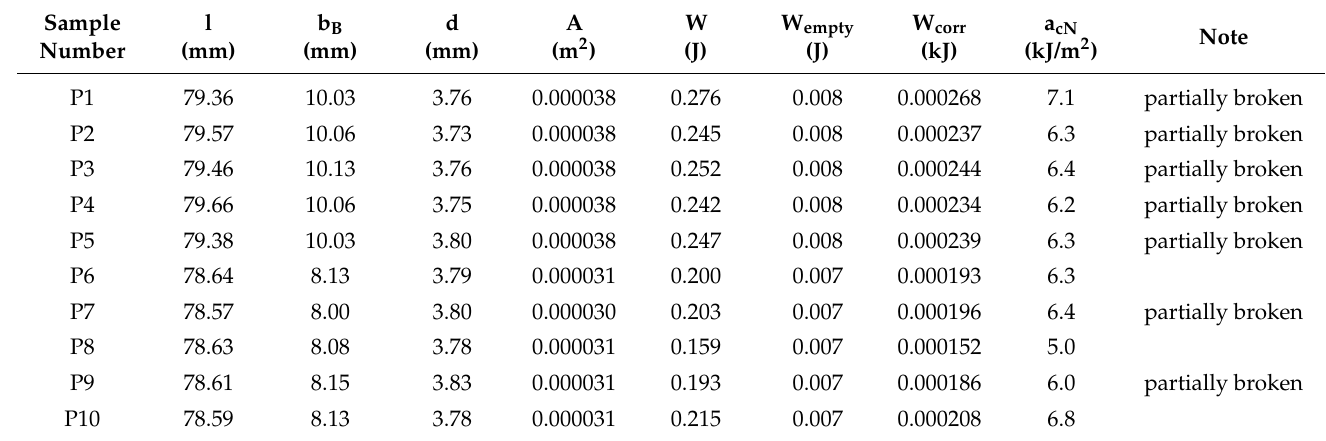
Table A18. Results of the notched impact tests and unnotched impact tests of PO_A.